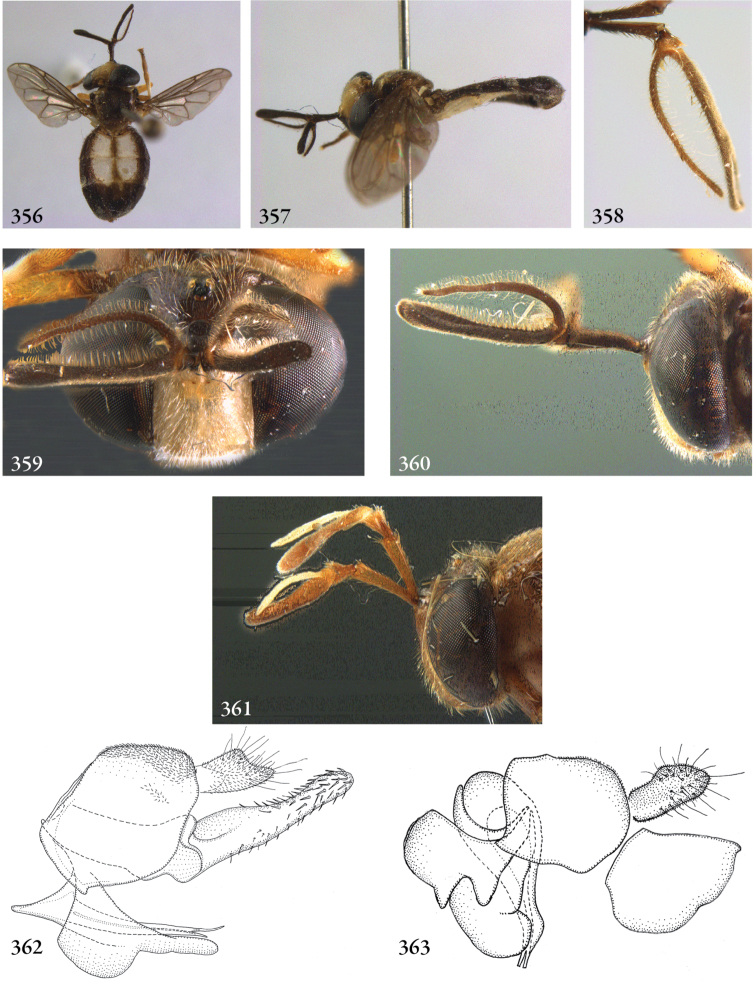
356–360
Schizoceratomyia barretoi male (Surinam, coll. RMNH): 356 habitus dorsal 357 habitus lateral 358 antenna 359 head frontal 360 head lateral 361
Schizoceratomyia barretoi female (Brazil, coll. RMNH), head lateral 362
Schizoceratomyia barretoi male (Surinam, coll. RMNH), genitalia lateral 363
Schizoceratomyia flavipes male (Surinam, coll. RMNH), genitalia lateral.